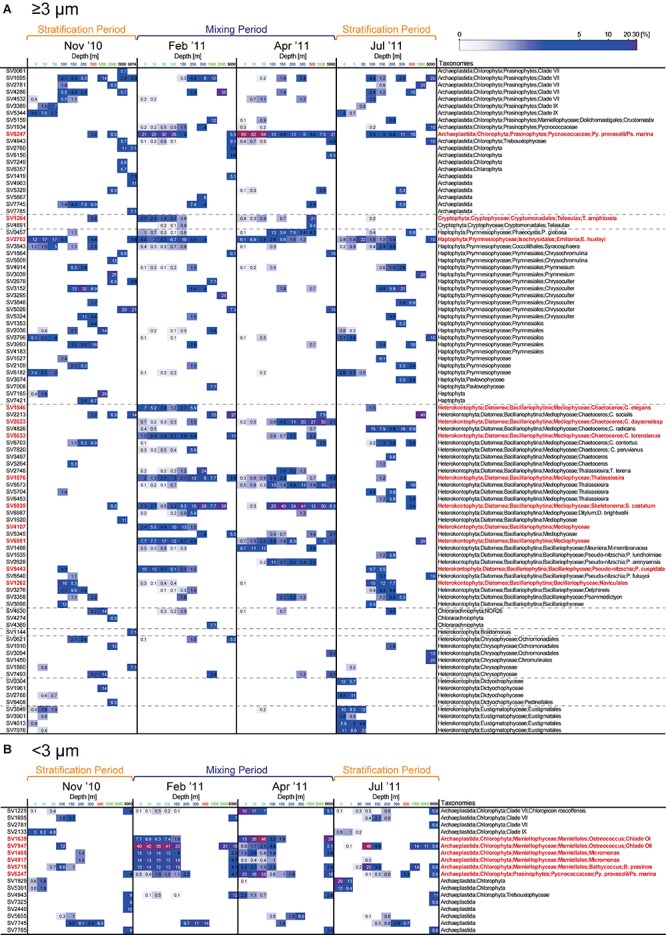
Heatmap of the relative abundance of representative sequence variants (SVs; ≥5% of total reads at a given depth) in the (A) ≥3-μm and (B) <3-μm size fractions. For the <3-μm size fraction, only SVs assigned to Archaeplastida are shown, while other SVs are shown in Supplementary Figure S5. Relative abundance is shown in white when it is >5%. The SVs noted in the text are shown in red.